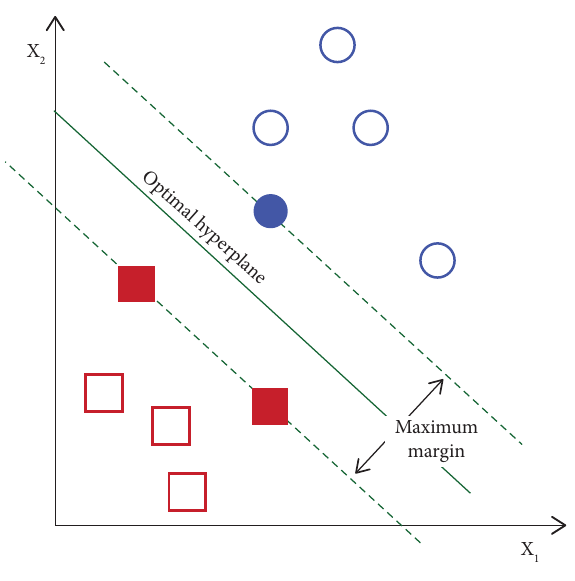
Figure 7: SVM hyperplane [26].